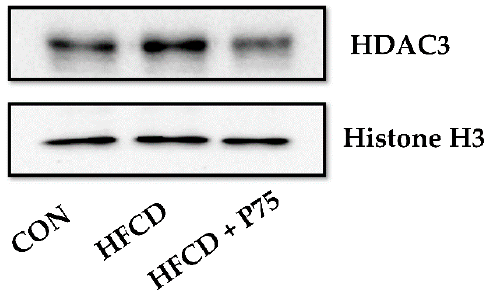
Figure 7. PEITC regulates HDAC3 in the livers of HFCD-fed mice: Immunoblotting was used to measure the levels of HDAC3. Equal loading of protein was ensured by stripping the immunoblot and reprobing it for histone H3. CON: AIN-93G diet, HFCD: 60% calories from fat + 1% cholesterol, HFCD + G: HFCD + 3 mg/kg/day GA, HFCD + P30: HFCD + 30 mg/kg/day PEITC, HFCD + P75: HFCD + 75 mg/kg/day PEITC.